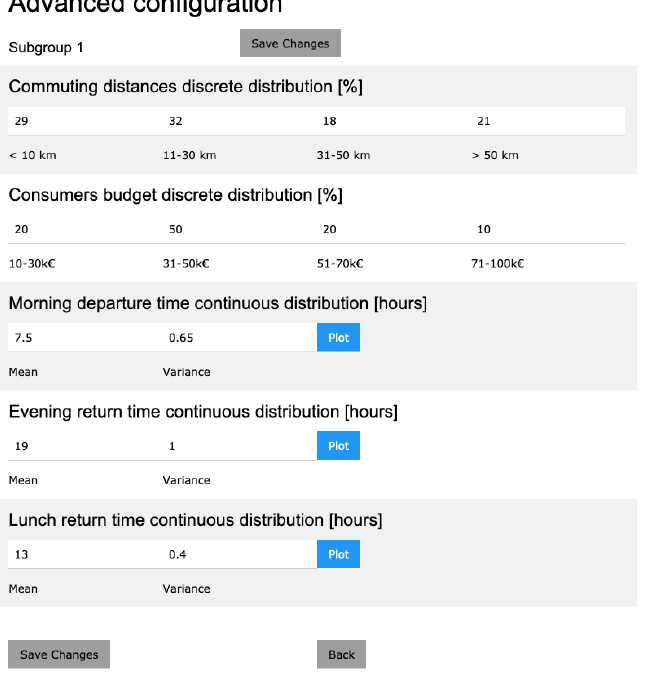
Figure 3. The user has access to a number of tweakable parameters for each subgroup, including commuting distance distribution and budget distribution (Figure 4), as well as morning, lunch and evening plugin/plugout time continuous distributions (Figure 5).